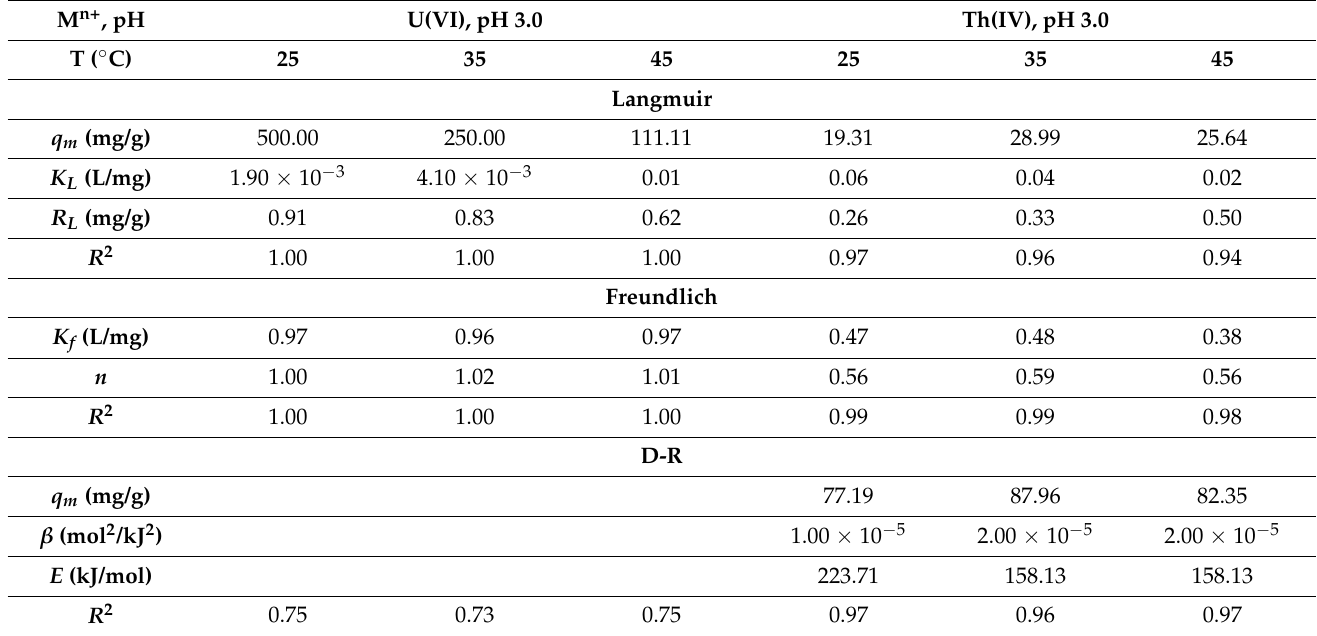
Table 4. Parameters Langmuir(II), Freundlich and D-R adsorption isotherm models at 25.0, 35.0,